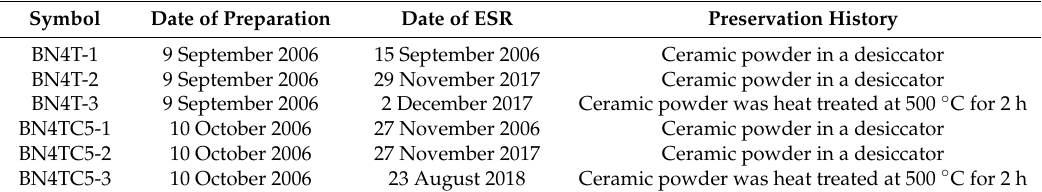
Table 1. Symbols and preservation history of BN4T and